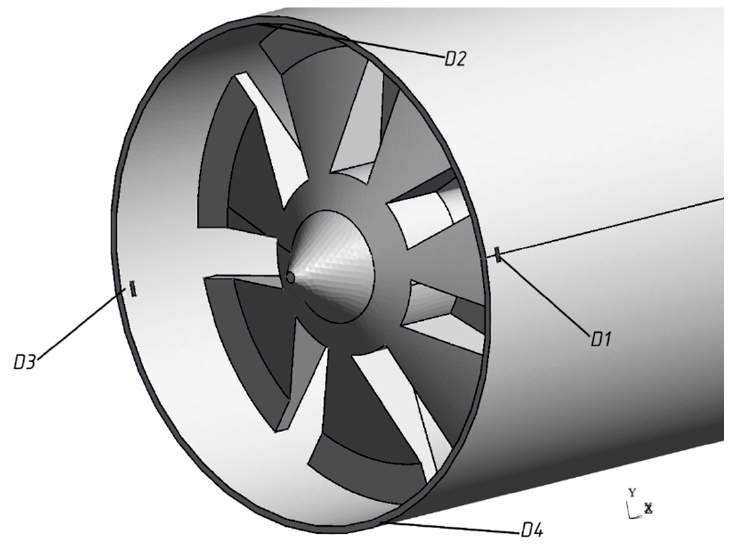
Figure 2. Arrangement of magneto-sensitive elements in shield housing grooves.